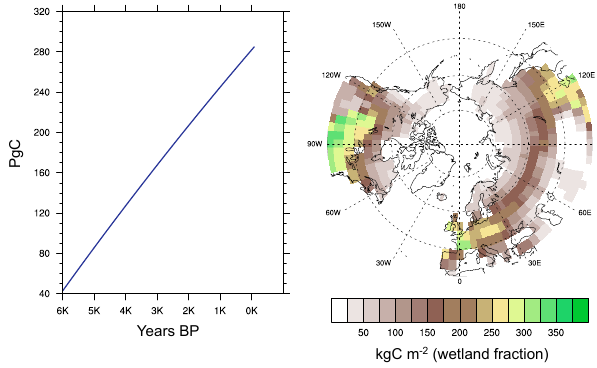
Fig. 5. Peat carbon (PgC) accumulated during a 6000yr peatBALANCE model run. Left panel: peatlands above 40 ◦ N. Right panel: peat carbon (kgCm − 2 ) in the wetland fraction of the model grid cells.